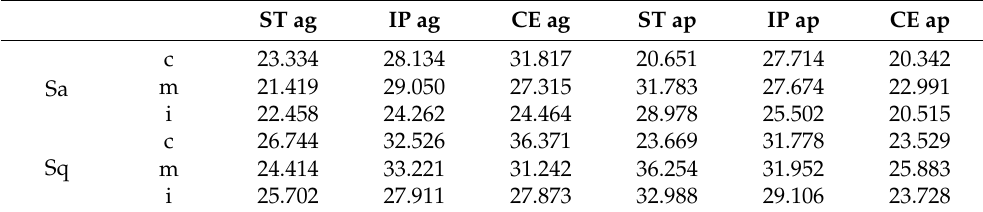
Sa = arithmetical mean height, Sq = root mean square height. ST = STML, IP= IPS e.maxZirCAD CEREC/in Lab MT Multi, CE = CeramillZolidfx ML. ag = aged-glazed, ap = aged-polished, c = cervical, m = medium, i = incisal. After aging, the AFM 3D images recorded the topography on each area of the glazed samples—Figure